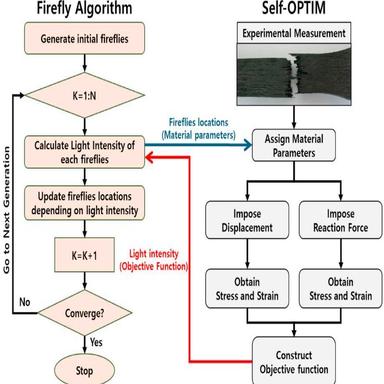
Schematic of the computational flow of the Self-OPTIM method.